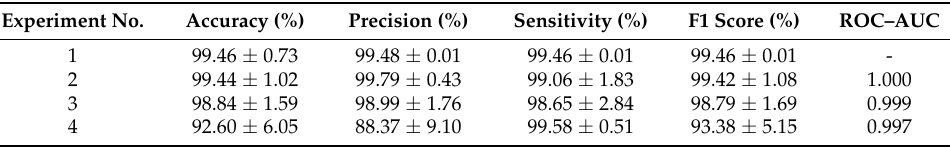
Table 5. Various performance values for each experiment. Standard deviation for all ROC–AUC scores was less than 0.01.